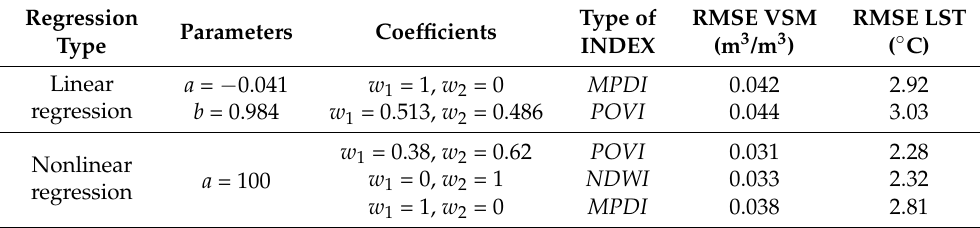
Figure 3. Scatter plots of POVI —versus transmissivity with linear regression. Table 2. VSM- and -LST- retrieval